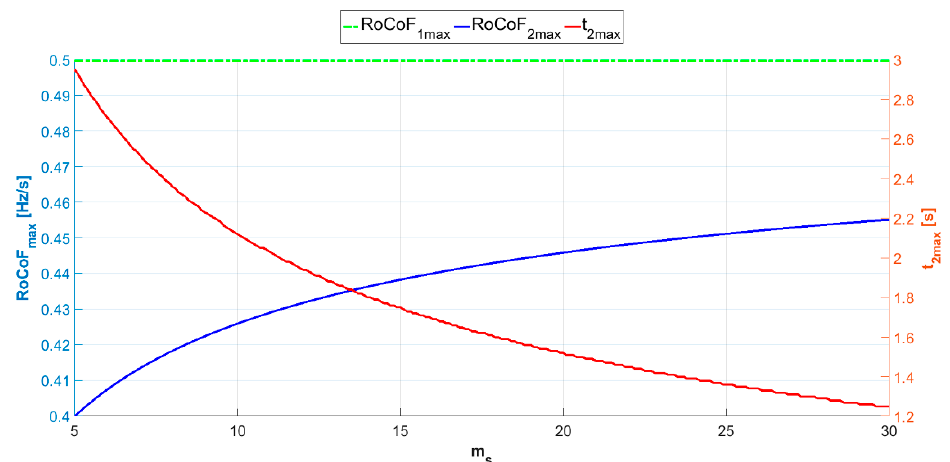
Figure 2. The maximum values of RoCoF in areas depending on area distance.